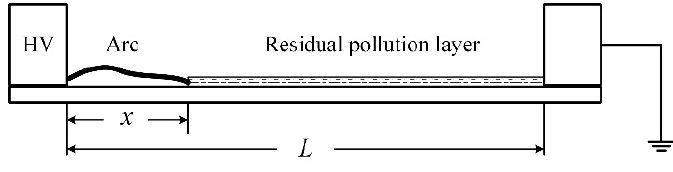
Figure 2. Obenaus circuit model.